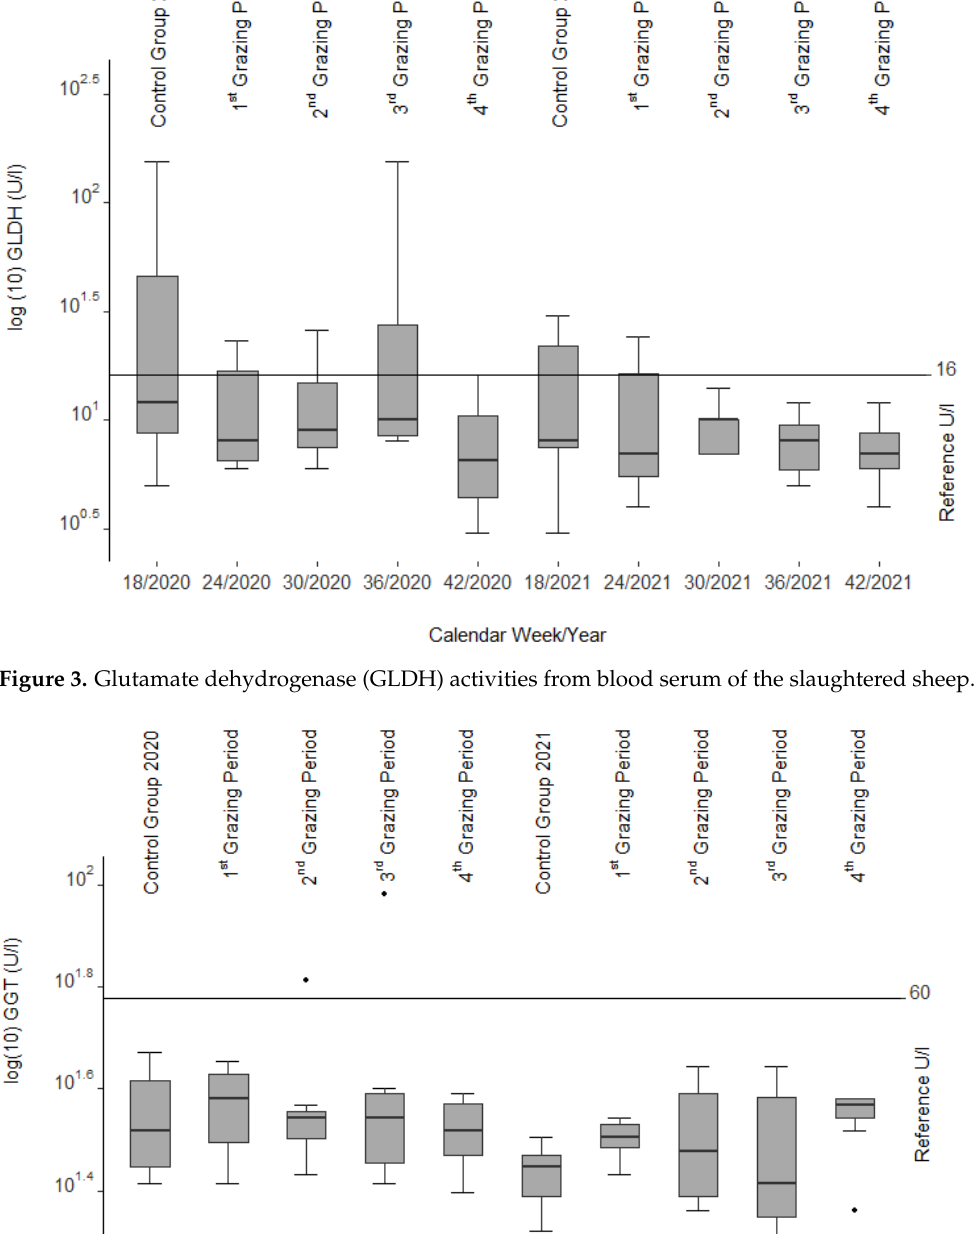
Figure 4. Gamma-glutamyl transferase (GGT) activities from blood serum of the slaughtered sheep. Note the three single statistical